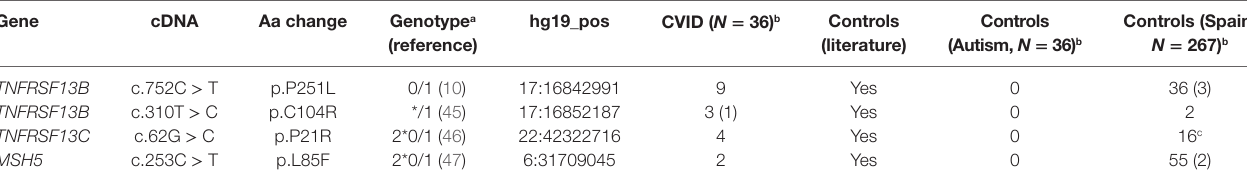
TaBle 1 | Known common variable immunodeficiency (CVID) variants detected in CVID patients in this study. gene cDna aa